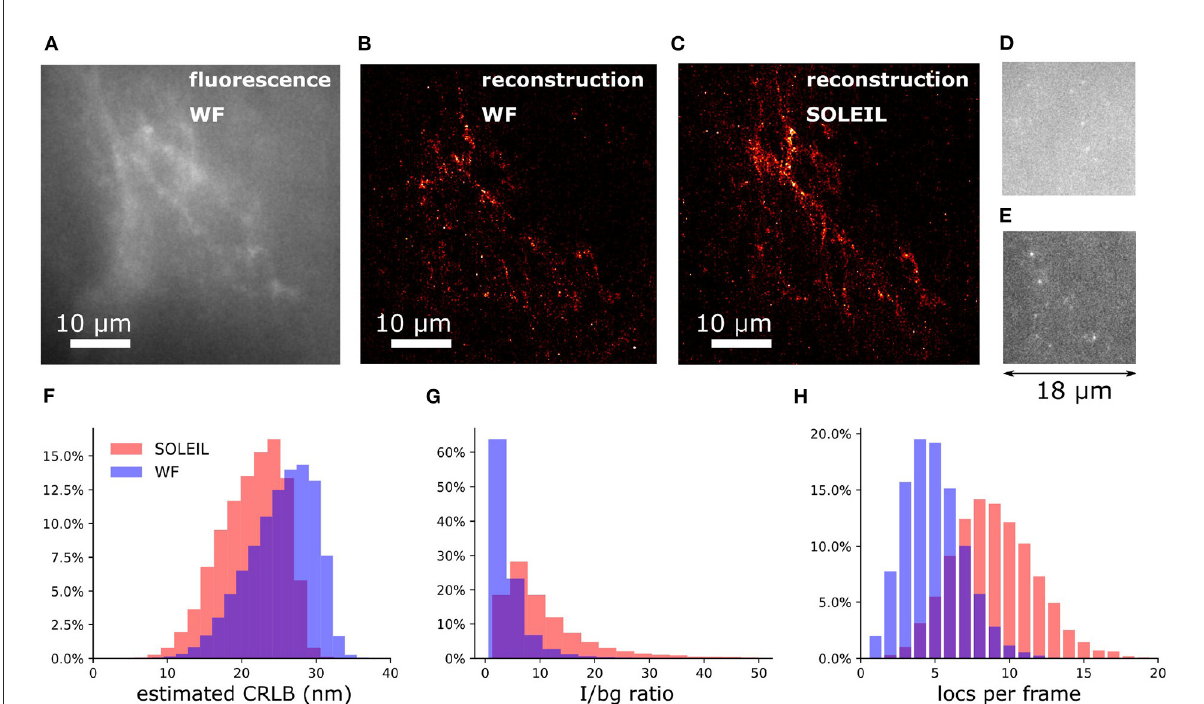
FIGURE12 2D SMLM of a single neuron in an whole adult Drosophila brain. The imaging depth was 30 µ m. (A) Fluorescence images of the same FOV of (B,C) with widefield microscopy. The fluorescence signal was acquired with low laser intensity to avoid blinking. (B) SMLM reconstruction of Drosophila brain with widefield microscopy. (C) SMLM reconstruction of Drosophila brain with SOLEIL microscopy. (D,E) Raw dSTORM images with widefield and SOLEIL microscopy. The images was plot in same contrast to fairly visualize the background reduction. (F–H) The estimated CRLB, I/bg ratio, and number of localization per frame (locs per frame) of widefield and SOLEIL